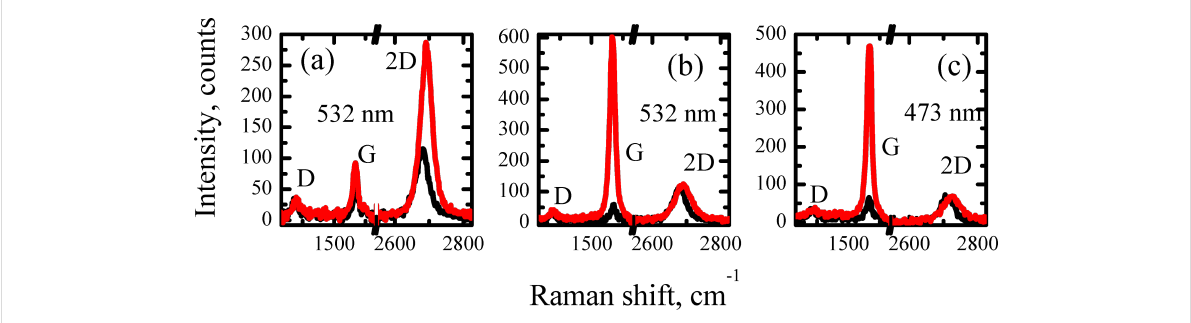
Figure 11: Raman spectra of sample B on SiO 2 /Si substrate. (a) Raman spectra of SLG (black) and double layer graphene (red) with the laser excita- tion wavelength of 532 nm. (b) Raman spectra of SLG (black) and double layer graphene with the G resonance (red) with the laser excitation wave- length of 532 nm. (c) Raman spectra of SLG (black) and double layer graphene with the G resonance (red) with the laser excitation wavelength of 473 nm.